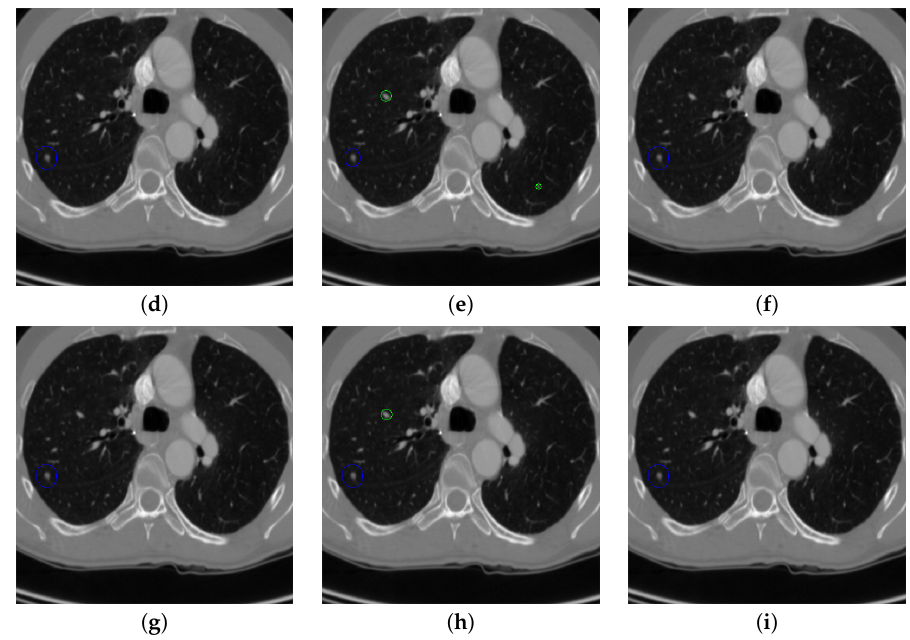
Figure 17. The result of detecting pulmonary nodules by different methods on one example image in LUNA16 dataset. Red circle represents the ground truth region of nodules, blue circles represent the correct estimation of pulmonary nodules, green circles represent the over-detected nodules, while yellow circles denote the nodules being omitted. ( a – i ) are: ground truth nodule in the given chest CT image, nodule detected by 3D-FCN, MR-CNN, 3D-UNET, PRN-HSN, DCNN, CLAHE-SVM, MASK-RCNN and our proposed method.